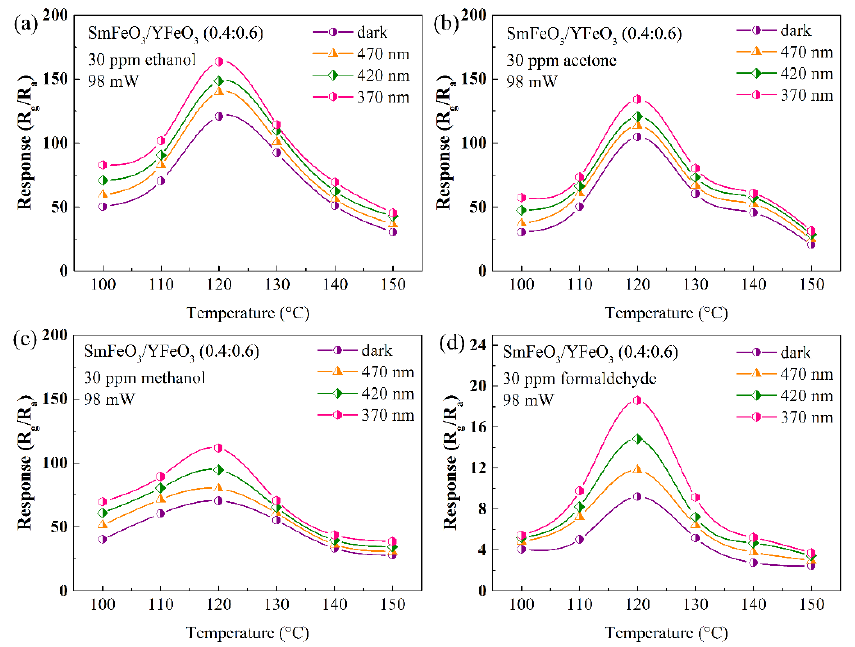
Figure 7. Response curves of the SmFeO 3 /YFeO 3 (0.4:0.6) sensor to VOC gases under multi-wavelength light illumination with temperature: ( a ) ethanol, ( b ) acetone, ( c ) methanol, and ( d ) formaldehyde.